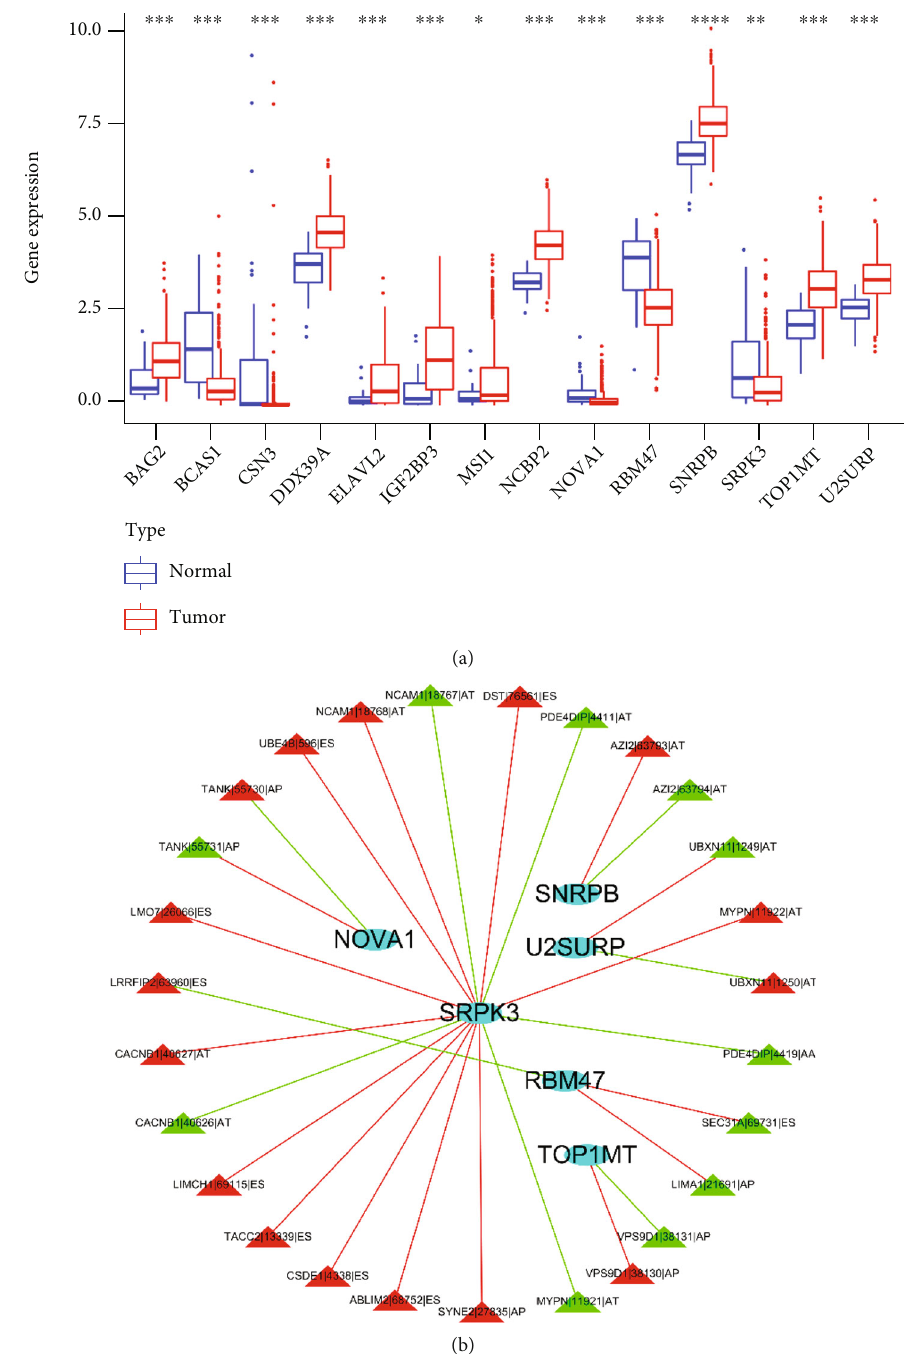
Figure 8: Analysis of the relationship between RMA-AS and splicing factors. (a) Expression of splicing factors in cancer and normal tissues. (b) The regulatory network of splicing factor-regulated RMA-AS. Oval represents splicing factors, the triangle represents RMA-AS, the red represents high-risk AS, and the green represents low-risk